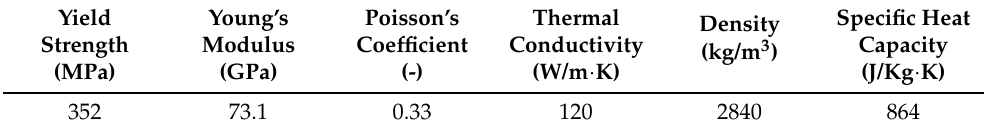
Table 3. Aluminum 2219-T851’s properties [40].